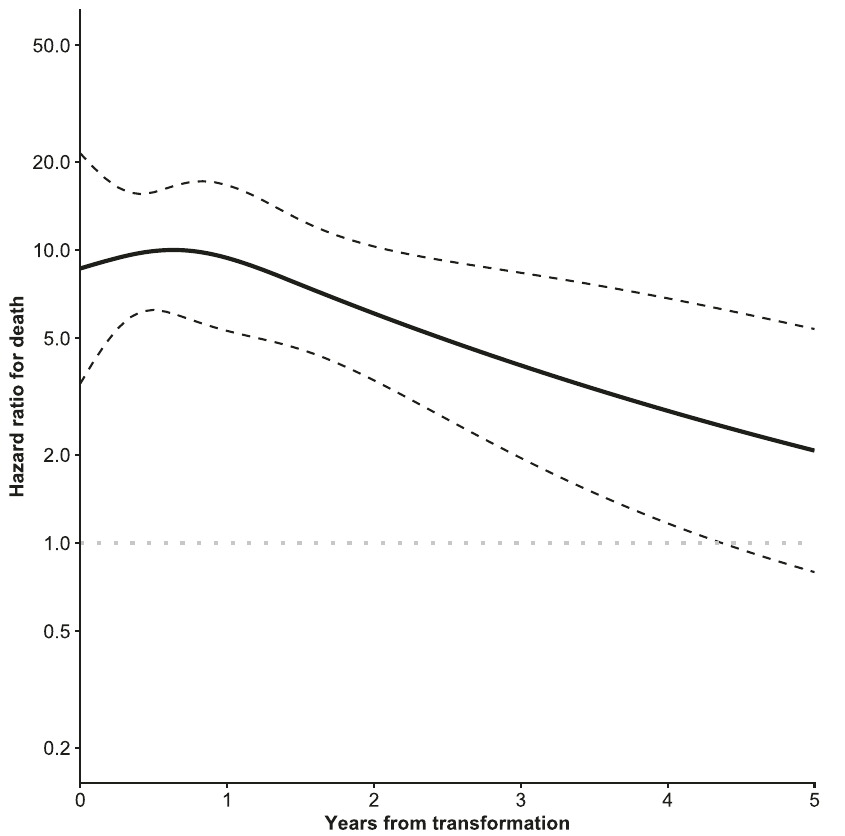
Fig. 3 Hazard ratio for death (on a logarithmic scale on the y-axis) by the time from transformation. The dashed lines indicate 95% con fi dence